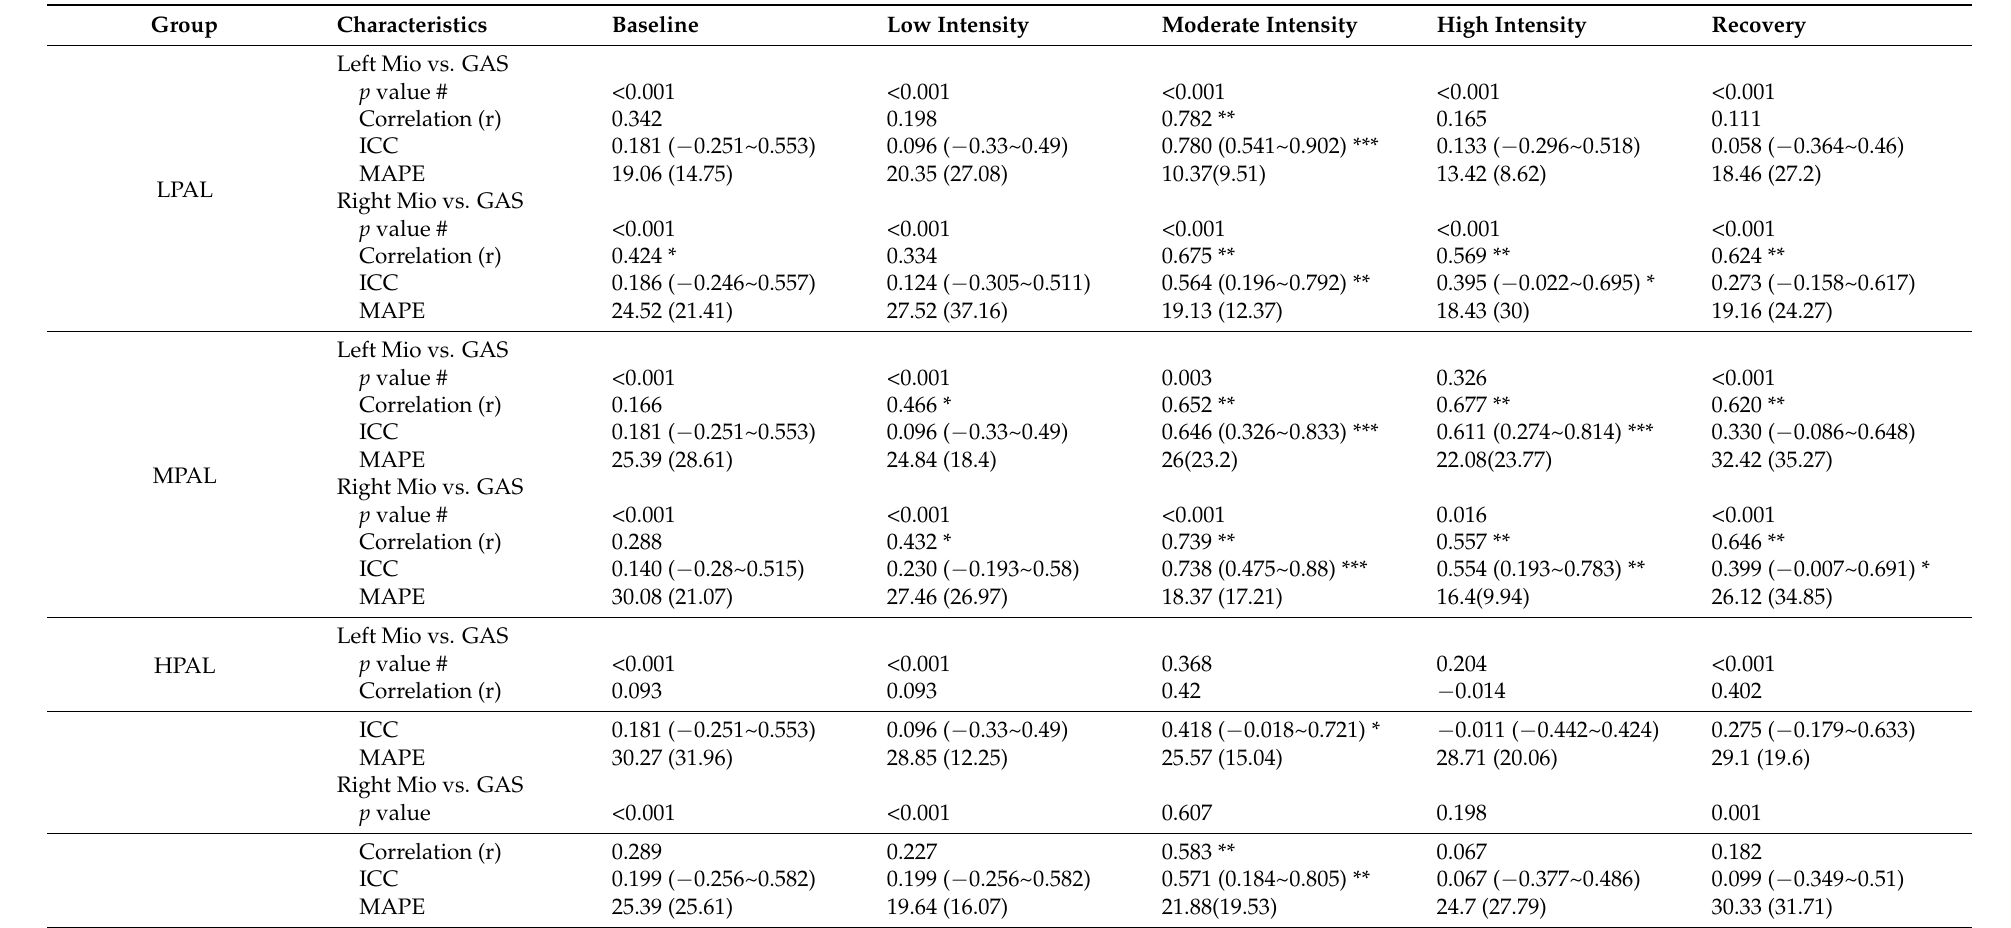
Table 7. Validity of Mio versus